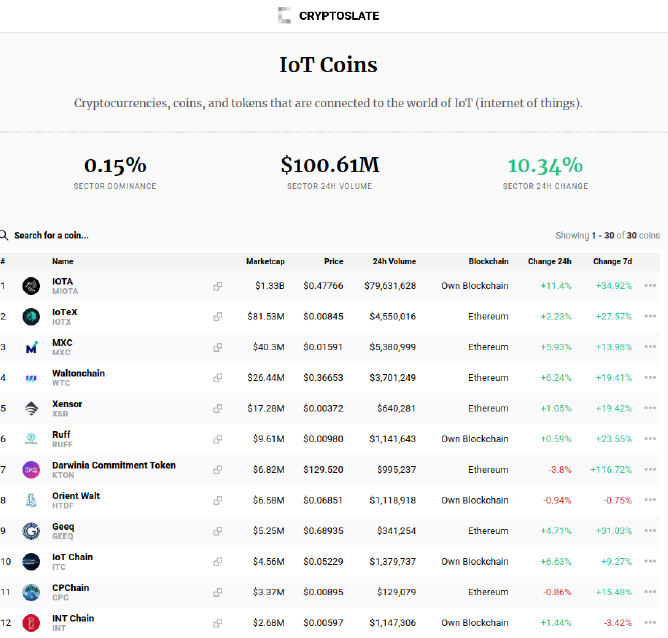
Figure 1. Market capitalisation of IoT coins on 18 January